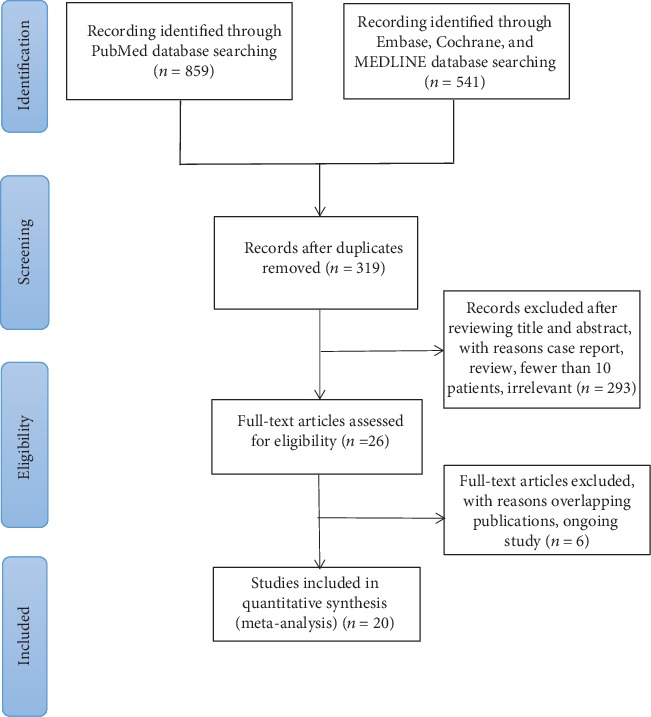
PSISMA flowchart.